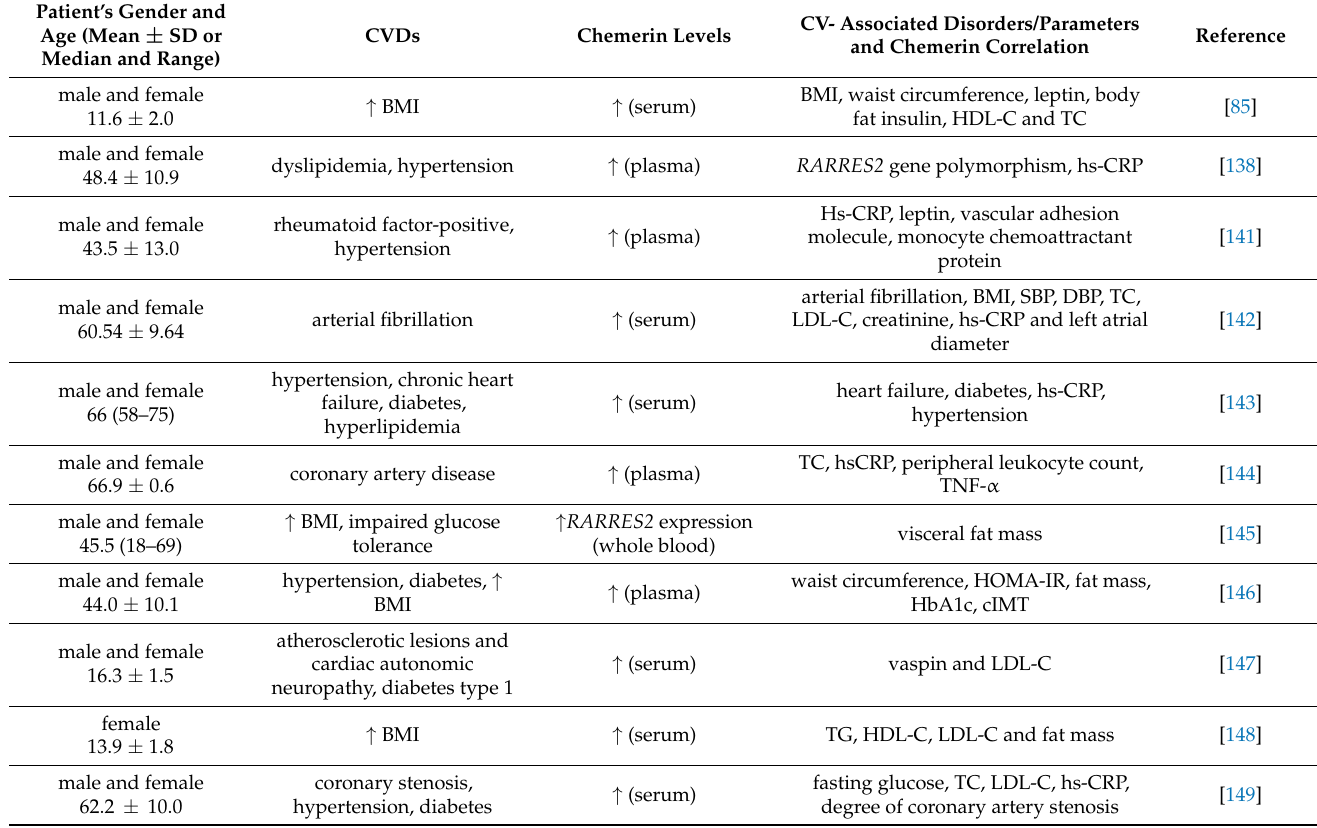
Table 1. Chemerin and CVDs: Evidence from human